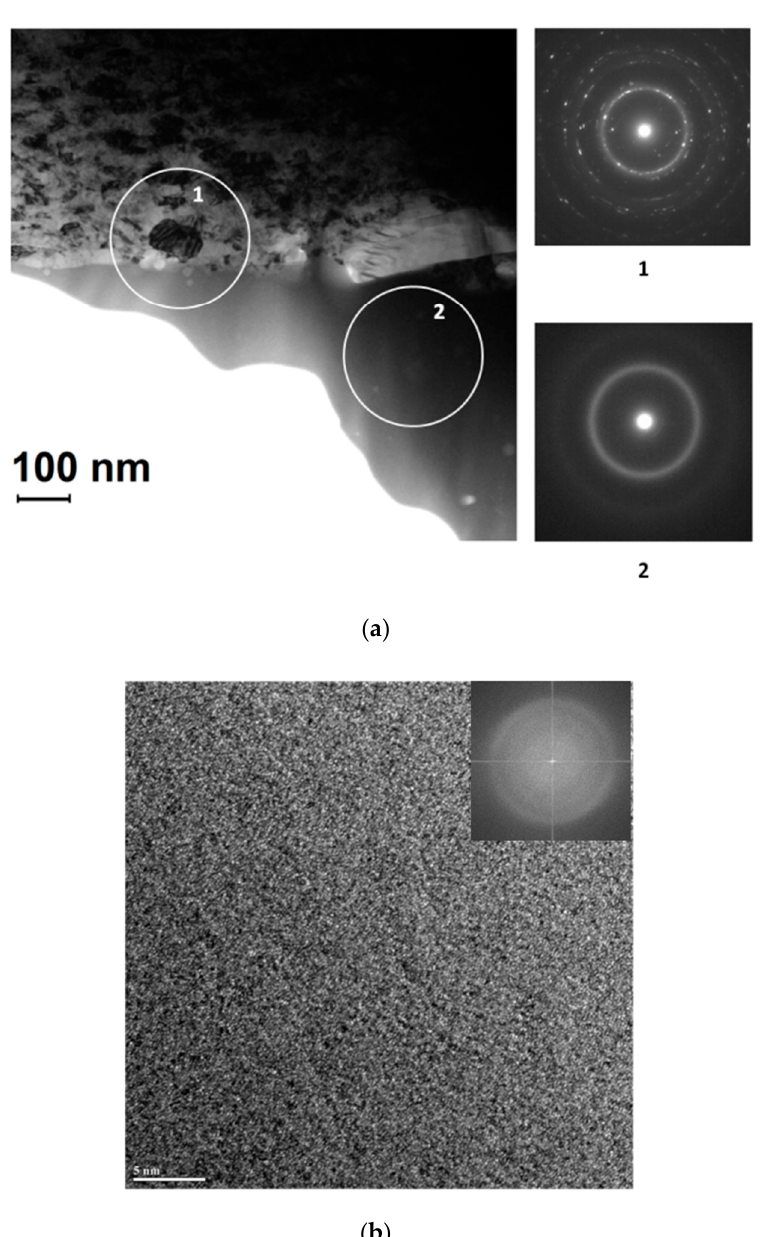
Figure 7. Transmission electron microscopy (TEM) bright-field image of the substrate/Fe 66 Cr 10 Nb 5 B 19 coating sample and selected-area electron diffraction patterns (SAEDP) ( a ), high-resolution TEM image of the coating structure and fast Fourier transform (inset) ( b ). Explosive charge 60%.